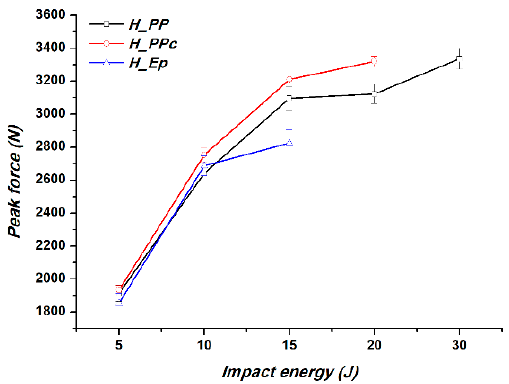
Figure 14. Peak force vs kinetic impact energy for flax/basalt hybrid composites as a function of matrix type.